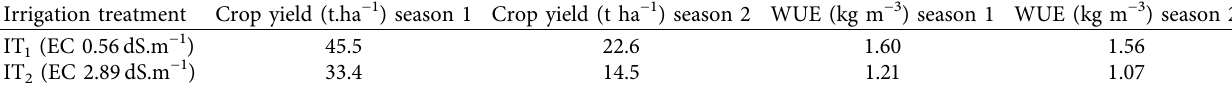
Table 5: Crop yield and water use efficiency.